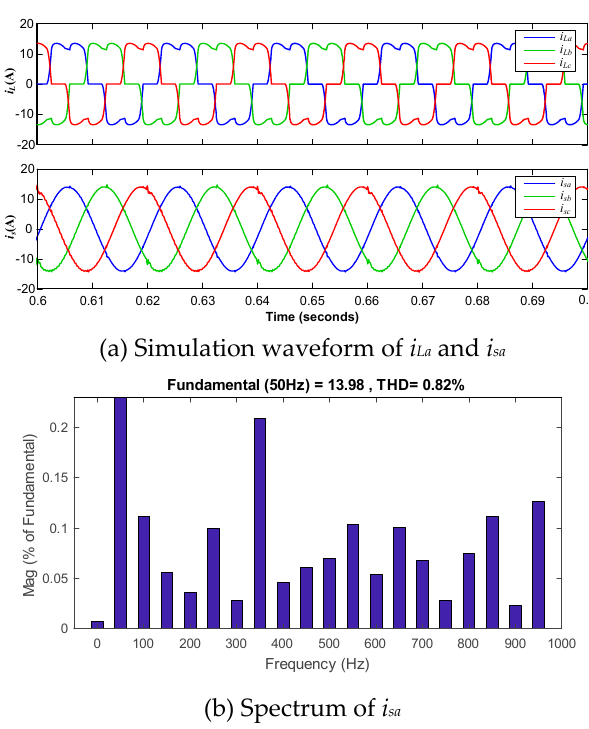
Figure 7. Simulation waveform of SAPF based on RCSMC in steady state.